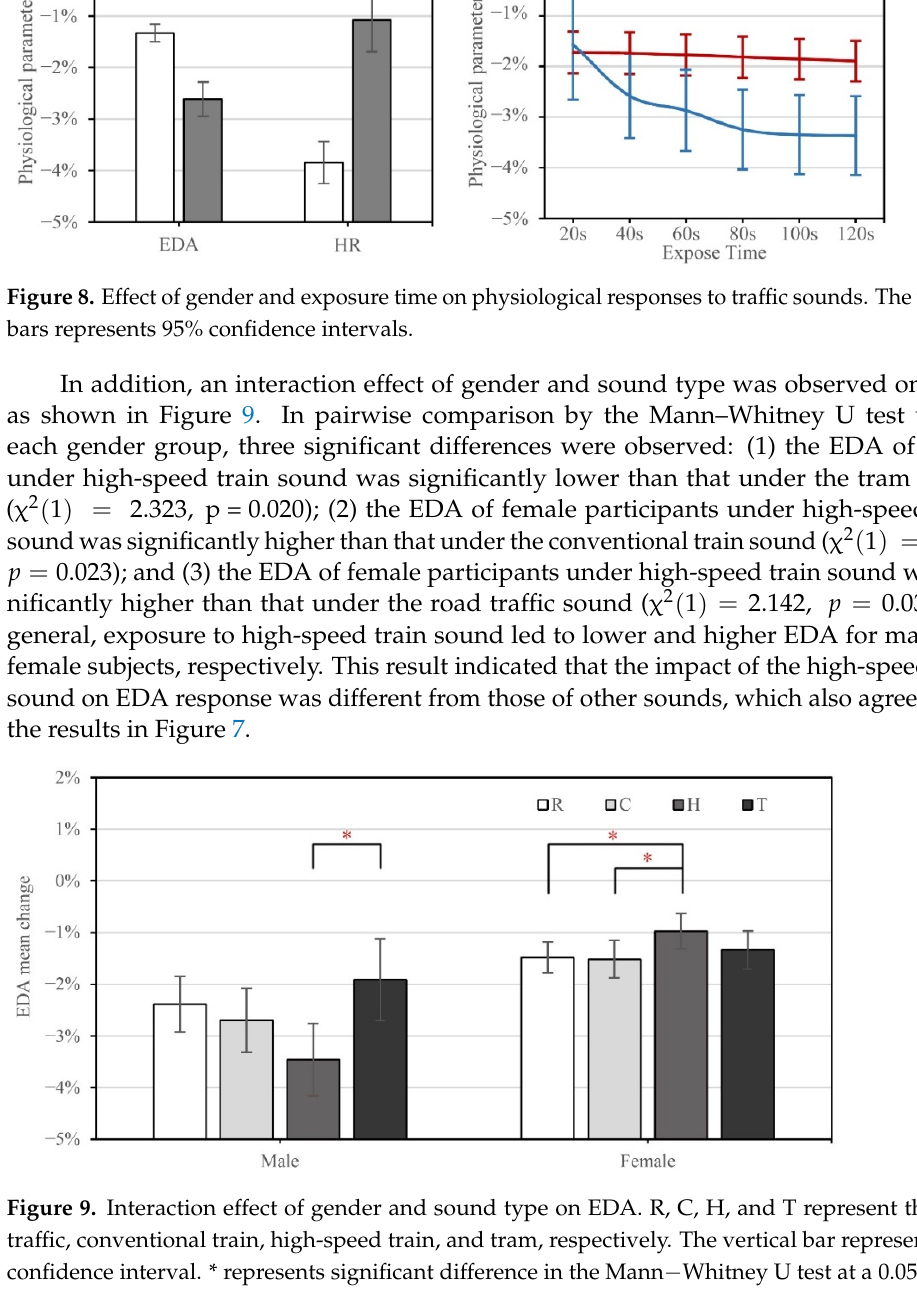
Figure 9. Interaction effect of gender and sound type on EDA. R, C, H, and T represent the road traffic, conventional train, high-speed train, and tram, respectively. The vertical bar represents 95% confidence interval. * represents significant difference in the Mann − Whitney U test at a 0.05 level.